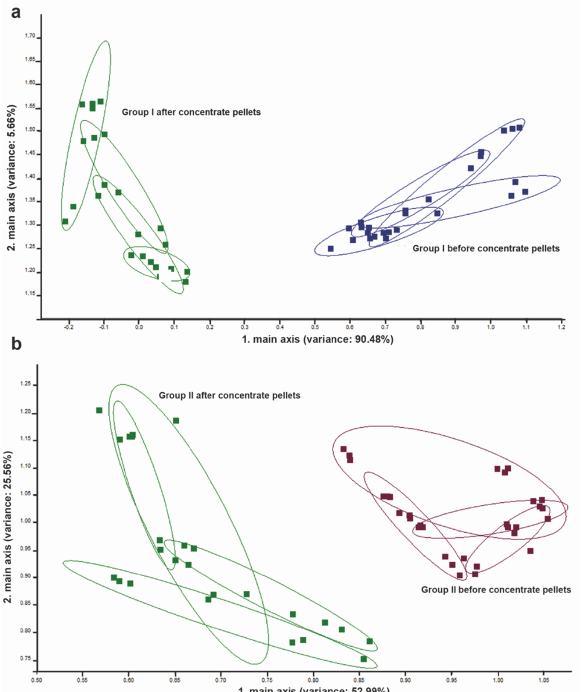
Figure 7. PCA for exhalated breath of cows before and after ingestion of pellet concentrates. ( a ) PCA for exhalated breath of cows from group I before and after the ingestion of pellet concentrates. ( b ) PCA for exhalated breaths of cows from group II before and after the ingestion of pellet concentrates. The numbers in parentheses indicate the percentages of the data matrix described by the relevant components and functions.